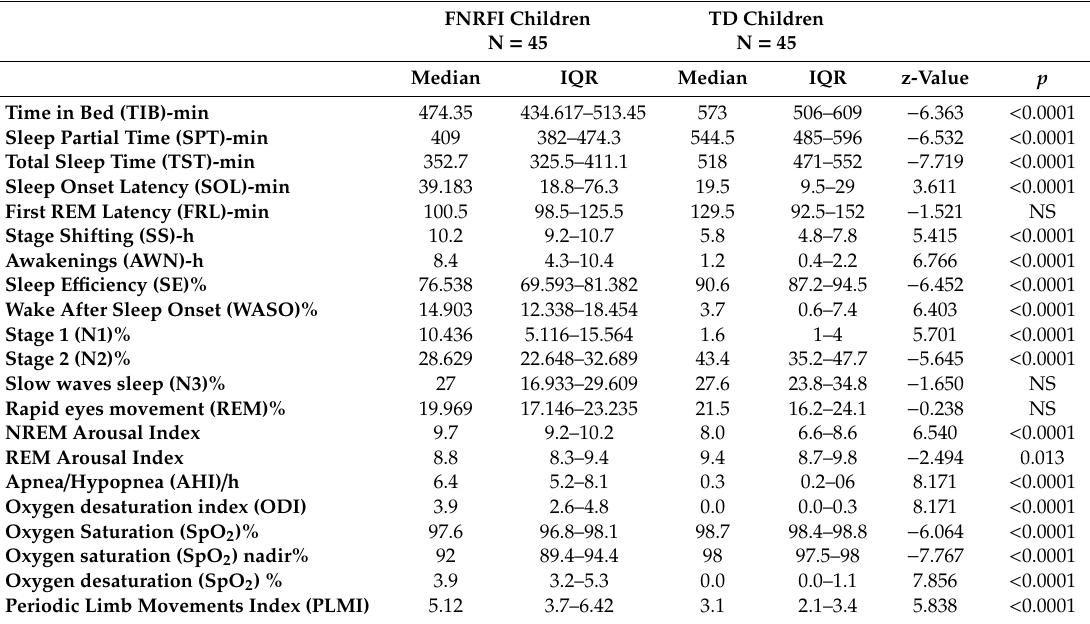
Table 2. Polysomnographic macrostructural parameters comparison between the groups (median, inter quartriles analysis; Mann-Whitney U